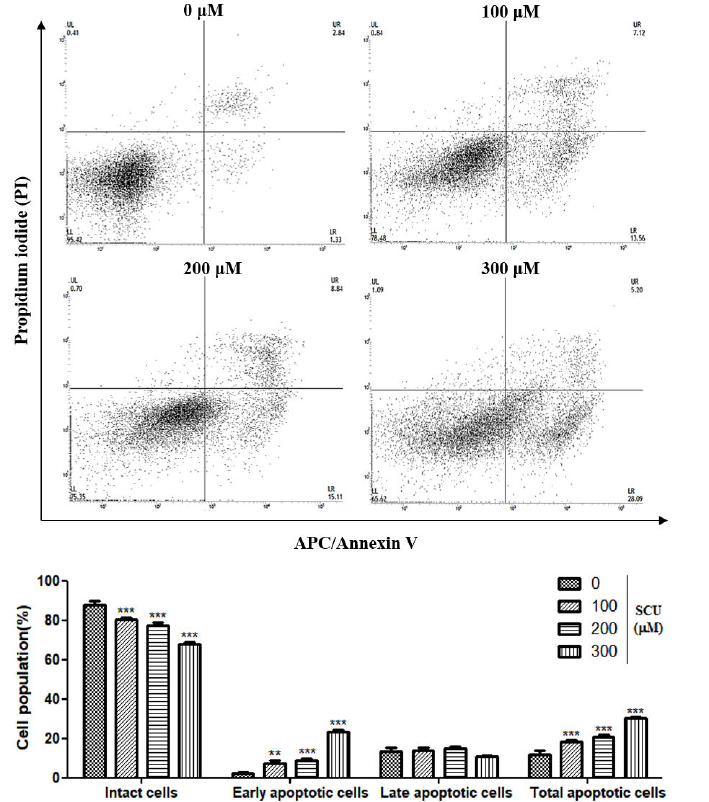
Figure 3. Scutellarein (SCU) induces apoptosis in Hep3B cells. To quantify the extent of SCU-induced apoptosis, the cells were untreated or treated with SCU at indicated concentrations (100-, 200-, and 300- µ M) for 24 h. Allophycocyanin (APC)/Annexin V and propidium iodide (PI) double-staining was performed which was analyzed by flow cytometry. Values are given as the mean ± standard error of the mean (SEM). ** p < 0.01 vs. Hep3B cell control, *** p < 0.001 vs. Hep3B cell